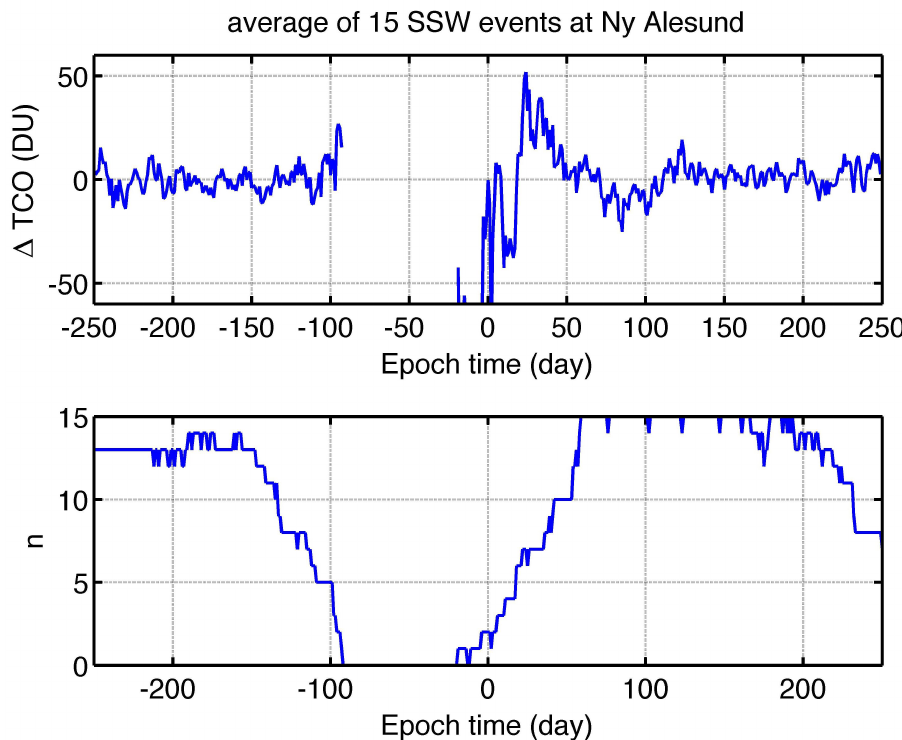
Figure 3. Composite of 15 major SSWs at Ny Ålesund (GBcomb data). The lower panel shows the number of measurements which were averaged in the composite shown in the upper